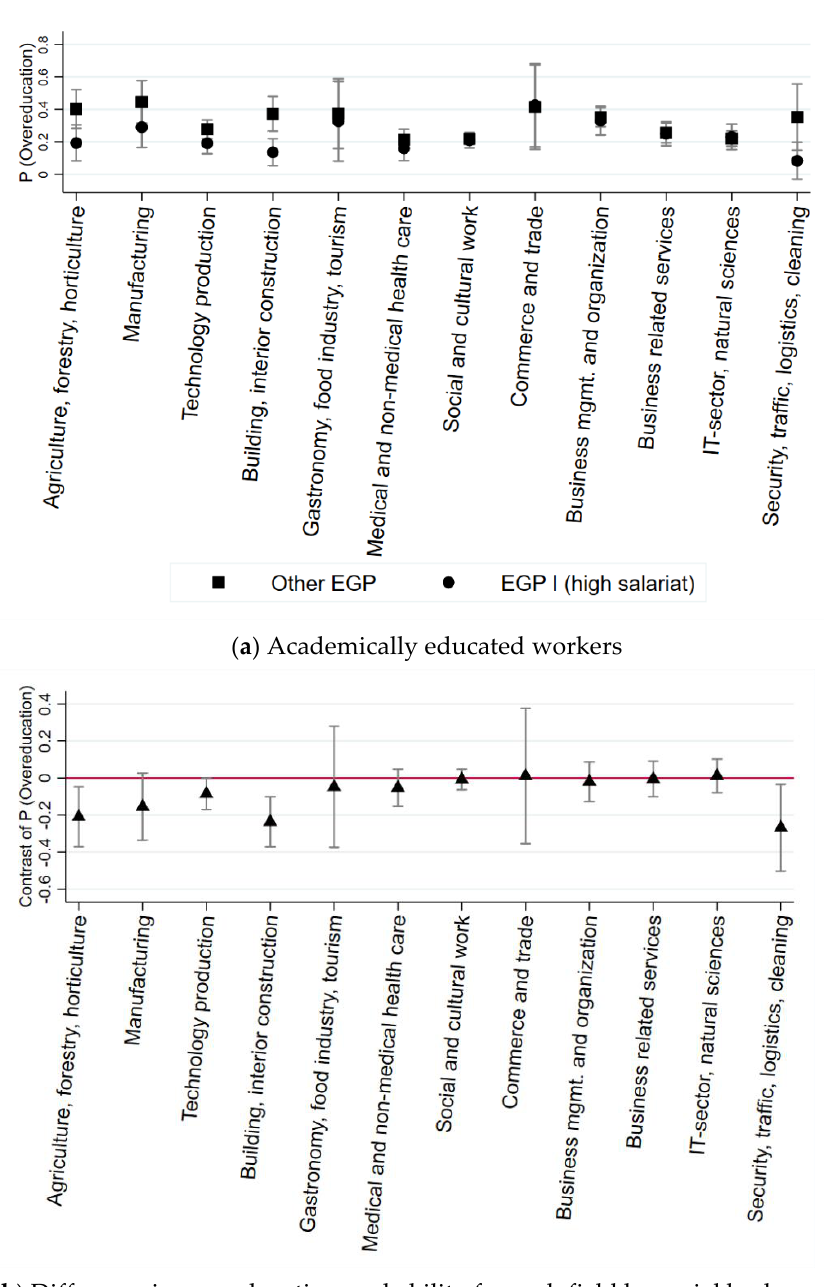
Figure 4. ( a ) Predicted probability of overeducation (subjective indicator) (AME) within academically educated workforce for each combination of educational field and social background; ( b ) social background differences (EGP I high salariat-other EGP) of predicted probability of overeducation. Confidence intervals at 95-percent level. Weighted results. Data: BIBB/BAuA Employment Survey 2018, authors’ own calculations.